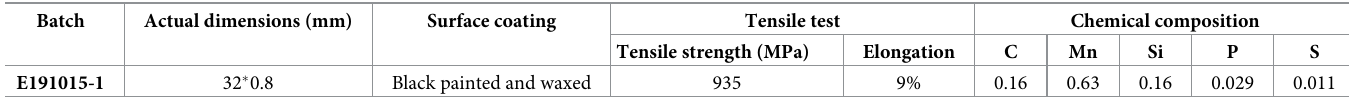
Table 5. Properties of the metal strap.